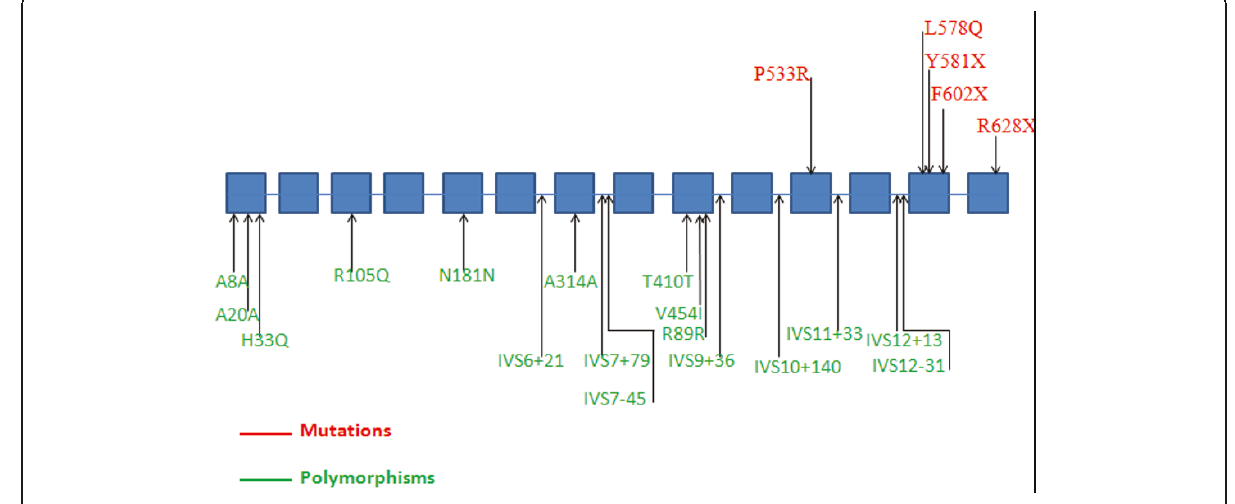
Figure 2 Mutations and polymorphisms of IDUA gene